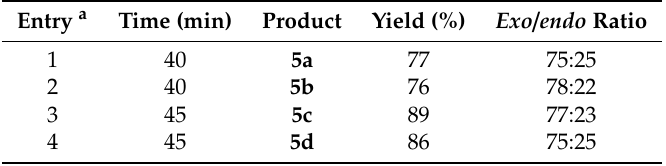
Table 1. Reaction conditions and results of s olvent-free synthesis of cycloadducts 5a – d . Entry a Time (min) Product Yield (%) Exo / endo Ratio 1 40 5a 77